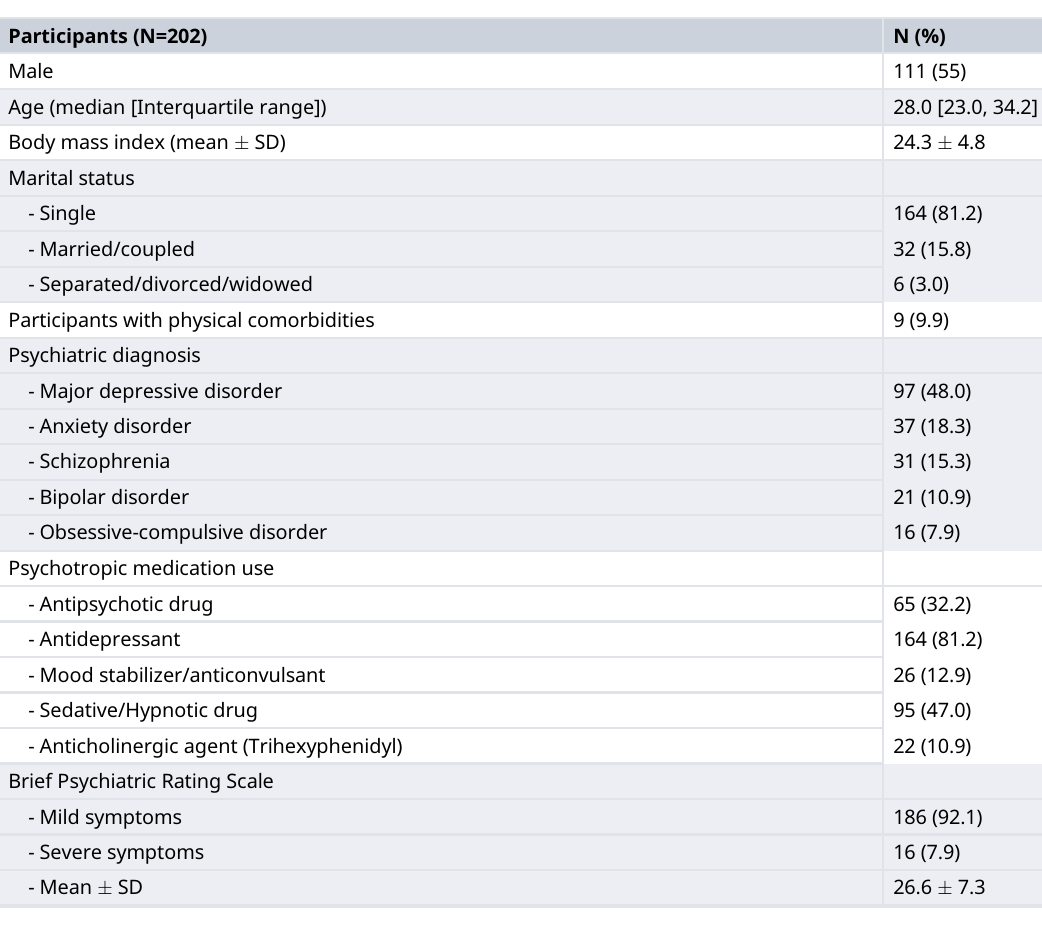
Table 1. Demographic